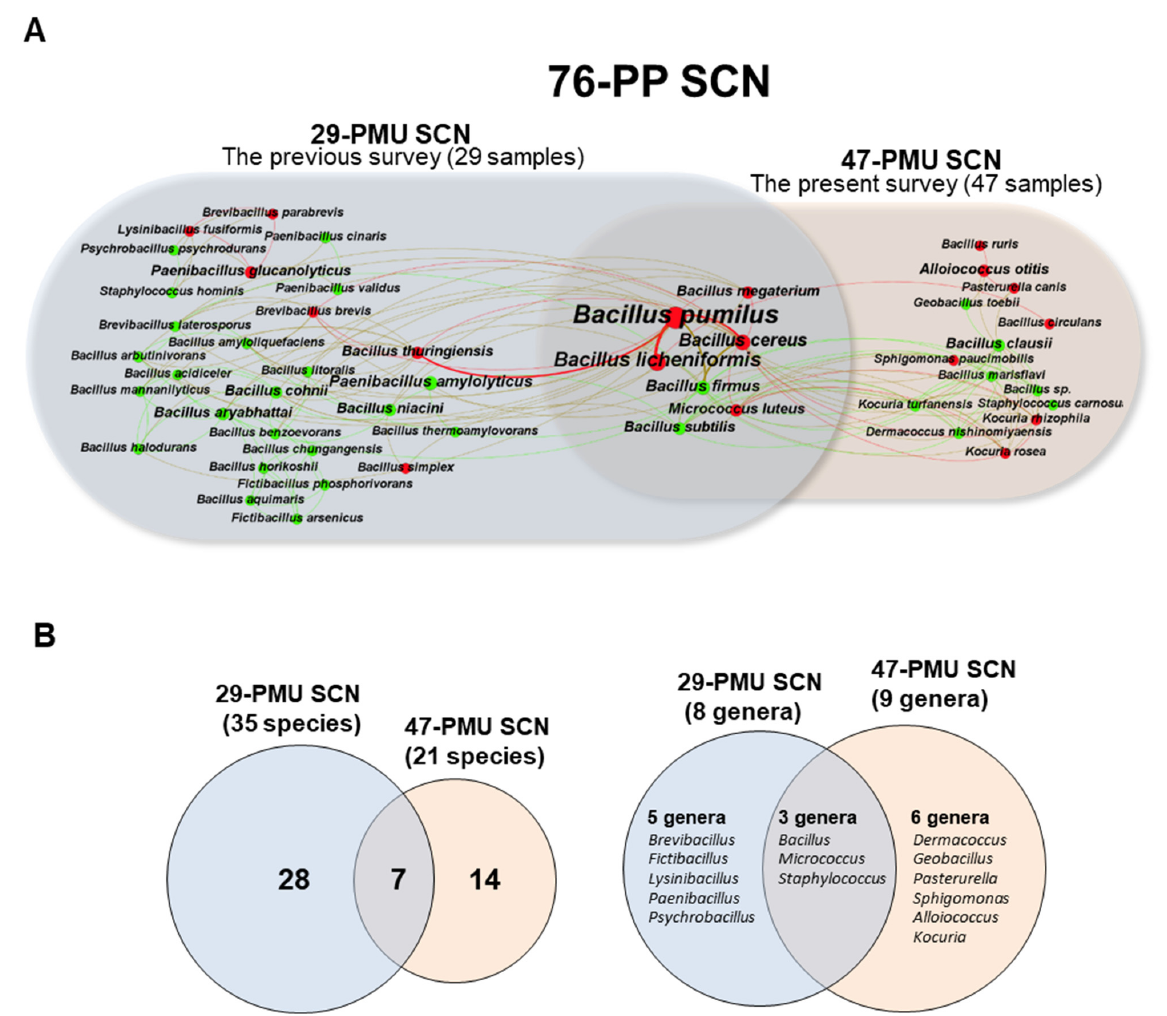
Figure 2. Comparative species-centric co-occurrence network analysis of the bacterial isolates from the previous and present PMU ink surveys. ( A ), a species-centric co-occurrence network (76-PP SCN) of the 76 PMU ink samples (29 samples of the previous survey and 47 samples of the present survey). In the network, color and size of the nodes indicate pathogenicity (red, pathogenic and green, nonpathogenic) and occurrence rate of the bacterial isolates from PMU ink samples, respectively. Thickness of the edges was weighted by co-occurrence rate. ( B ), Venn diagrams of the two subnetworks, 29-PMU SCN (the previous survey) and 47-PMU SCN (the present survey), at the species ( left ) and the genus level ( right ), respectively.